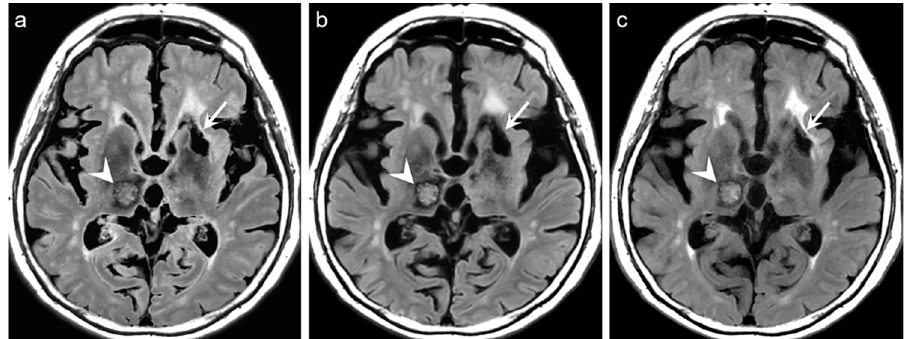
Figure 3. Representative case of lesion conspicuity on DL-FLAIR images. Focal marginal gliosis showing hyperintensity (arrows) is seen at the anterior aspect of the surgical cavity in the right cerebellum (a–c). The lesion is well delineated on the native synthetic FLAIR ( a ), DL-FLAIR ( b ), and conventional FLAIR images ( c ). However, the hyperintense lesion on the native synthetic FLAIR (arrow on a) is incompletely preserved on DL-FLAIR image (arrow on b), showing a decrease in the degree of its hyperintensity. Flow artifacts in the fourth ventricle on the native synthetic FLAIR (arrowhead on a) are successfully removed on DL-FLAIR image (arrowhead on b). Multiple FLAIR hyperintense lesions in both centrum semiovale, suggesting grade II small vessel disease on the native synthetic FLAIR ( d ) are well preserved on DL-FLAIR image ( e ). ( f ) Conventional FLAIR image is shown for comparison.